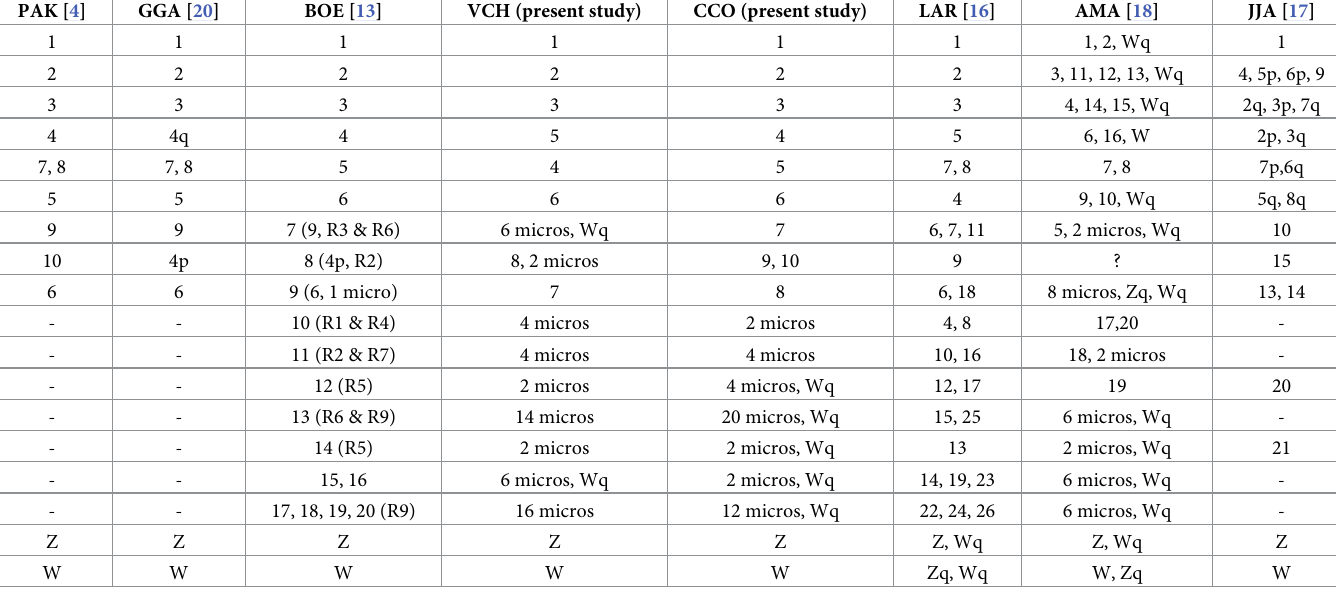
Table 1. Chromosomal correspondence between Gallus gallus (GGA), Burhinus oedicnemus (BOE), Vanellus chilensis (VCH), Charadrius collaris (CCO), Larus argentatus (LAR), Actitis macularius (AMA), and Jacana jacana (JJA) demonstrated by chromosome painting. The numbers of chromosome pairs are those of the species karyotype. They are compared with the Putative Ancestral Avian Karyotype (PAK). Micro = microchromosome.? = Hybridization did not work. PAK